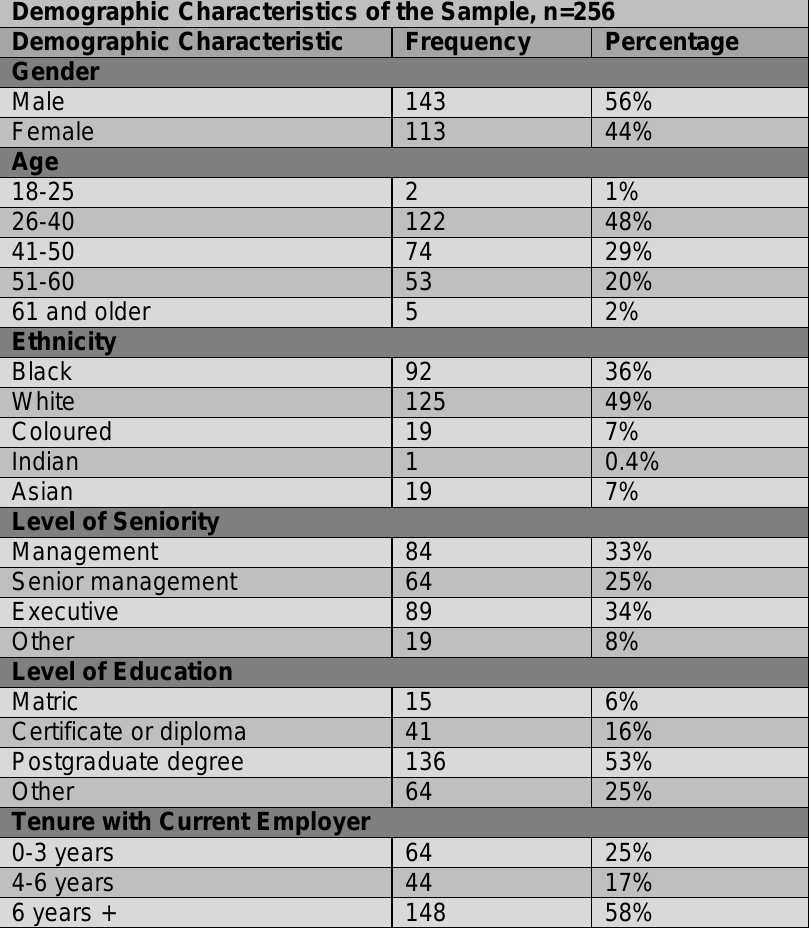
Table 2. Demographic Characteristics of the Sample Demographic Characteristics of the Sample, n=256 Demographic